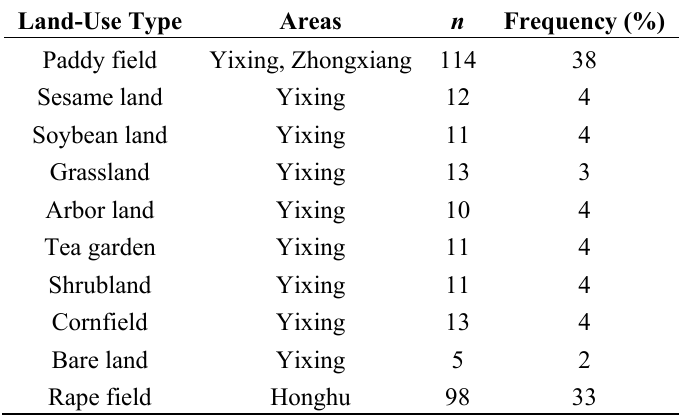
Table 1. The number of soil samples ( n ) and frequency (in percent of the total number of soil samples) occupied by land use type in the Yixing, Zhongxiang and Honghu regions.